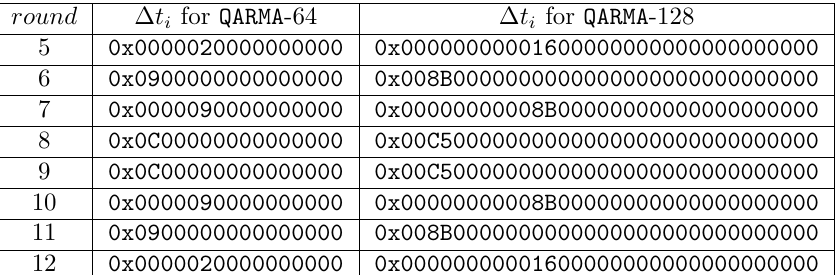
Table 9: Difference of Round Tweak for No. 4